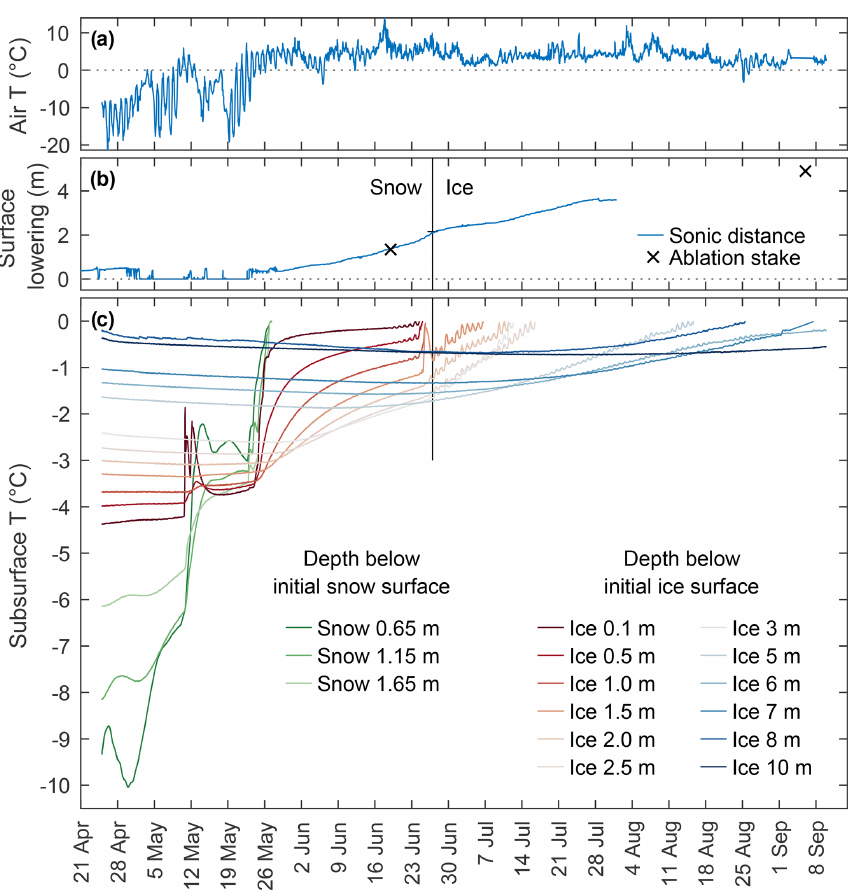
Figure 5. Hourly ice and snow temperature ( T ) measurements from thermistors installed at depth in the snow and ice adjacent to the On-Ice weather station in 2013 (c) . Panel (a) shows air temperature, and (b) shows cumulative surface lowering measured by the sonic ranger and ablation stakes. Initial thermistor depths are listed in the legend given in depth below the initial snow surface for the three snow thermistors and depth below the snow–ice surface interface for the 12 ice thermistors. The snow depth at installation on 19 April 2013 was 2.10m. Note that the instrumentation depth becomes shallower as the glacier surface ablates during the melt season. The onset of large diurnal temperature fluctuations above 0 ◦ C indicates that the thermistors have melted out and are affected by solar radiation. After a sensor exceeds 0 ◦ C, we do not plot the remaining